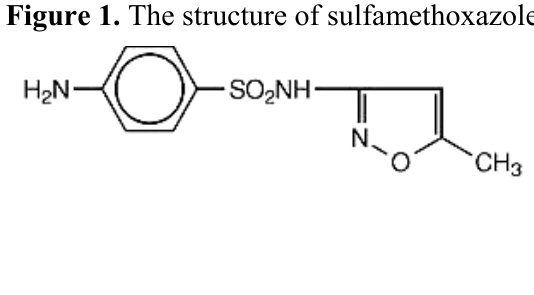
Figure 1. The structure of